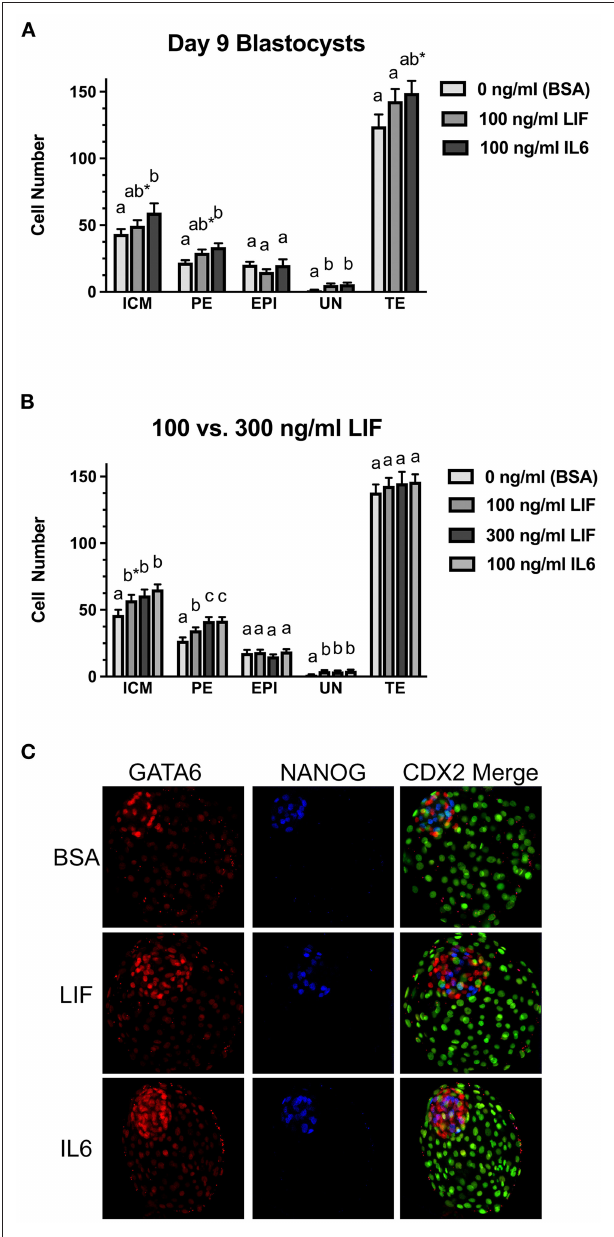
FIGURE 3 | Comparison of LIF vs. IL6 supplementation on day 9 blastocyst cell numbers. (A) Effects of 100ng/ml IL6 or 100ng/ml LIF on inner cell mass (ICM), primitive endoderm (PE), epiblast (EPI), undetermined (UN), and trophectoderm (TE) cell numbers in day 9 blastocysts ( n = 27–29 blastocyst/treatment/timepoint over 3 replicates). (B) Effects of 100ng/ml IL6 or either 100 or 300ng/ml LIF on ICM, PE, EPI, UN, and TE cell numbers in day 9 blastocysts ( n = 36–45 blastocysts/treatment over 3 replicates). Different superscripts for each endpoint indicate differences ( P < 0.05). The asterisks (*) indicate a tendency for a difference between the control (BSA only) and 100ng/ml LIF within the ICM ( P = 0.09) and a tendency for a difference between the control (BSA only) and 100ng/ml IL6 within the TE ( P = 0.09). (C) Examples of day 9 blastocysts treated with BSA (control, no treatment), 300ng/ml LIF (LIF) or 100ng/ml IL6 (IL6). Green signals represent CDX2 + cells in the far-right